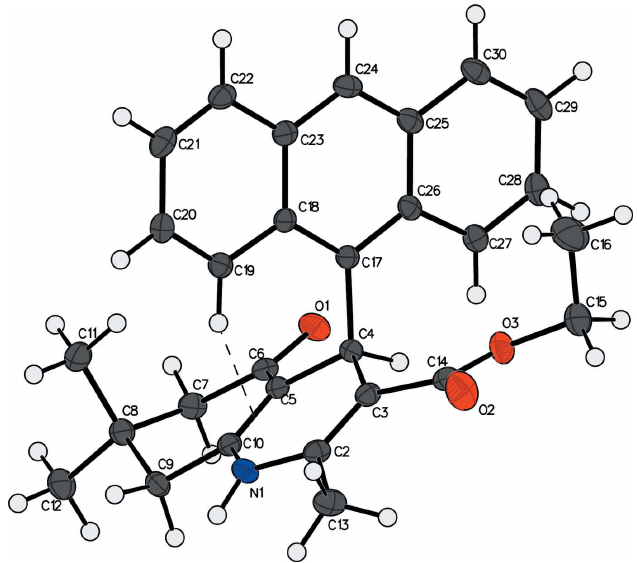
Figure 4 The asymmetric unit of compound III showing the atom-labeling scheme. Displacement ellipsoids are drawn at the 50% probability level. The C— H (cid:2)(cid:2)(cid:2) (cid:2) interaction is indicated by a dashed line.